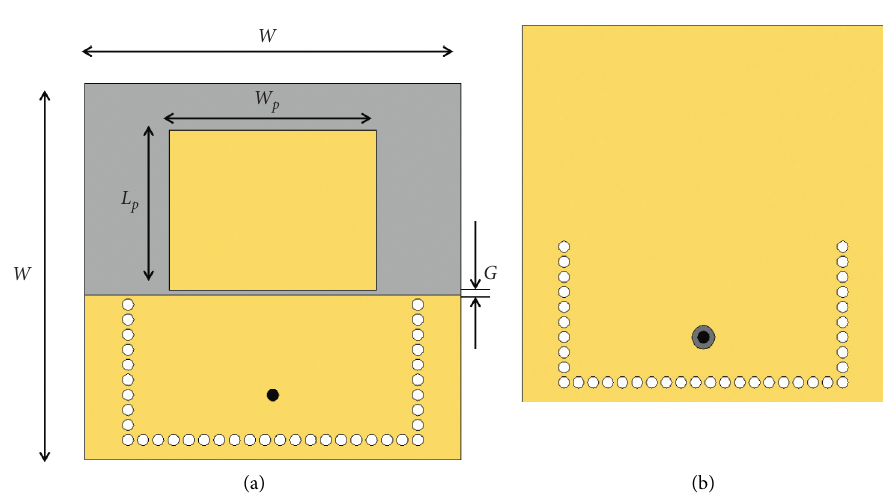
Figure 2: Geometry of the proposed dual-band antenna element. (a) Top view and (b) bottom view.